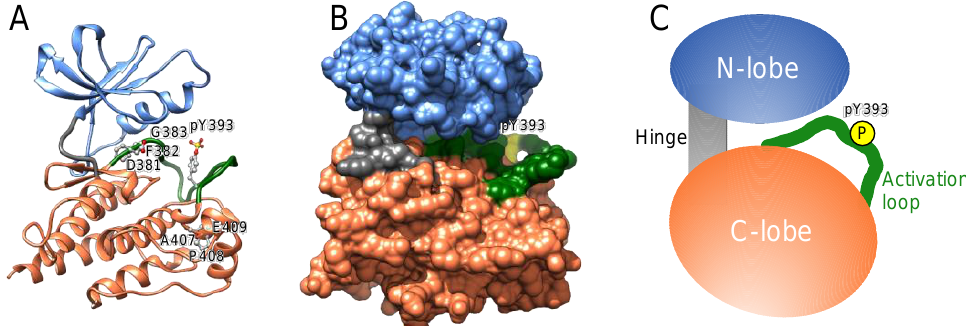
Figure 1. Structure of the kinase domain. ( A ) Ribbon representation of the kinase domain of ABL (Protein Data Bank (PDB) ID: 2V7A). Blue and orange regions indicate the N- and C-lobes, respectively. Gray and green loops represent the hinge region and activation loop, respectively. The tyrosine residue at position 393 in the activation loop is phosphorylated as indicated. The conserved amino acid residues (DFG and APE motifs) in and around the activation loop are also indicated. ( B ) Molecular surface image of the ABL domain (PDB ID: 2V7A), in which the colors are identical to the regions shown in ( A ). ATP binds to the cleft between the N- and C-lobes. ( C ) Graphical representation of the kinase domain.